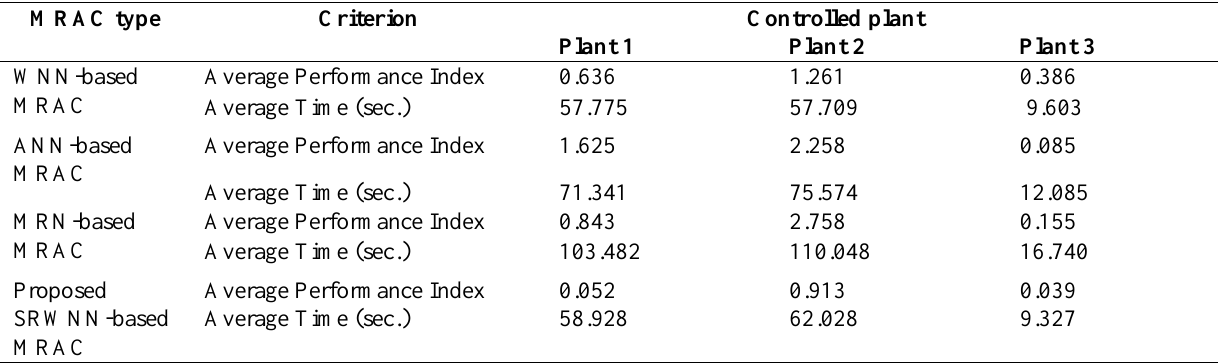
Comparison results of the WNN, the ANN, the MRN, and the proposed